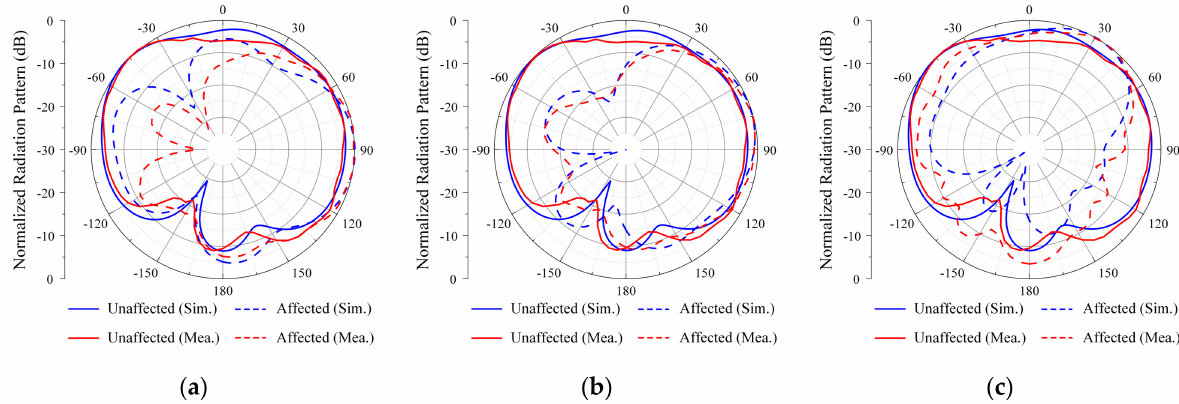
Figure 13. Simulated and measured normalized radiation of the IFA in the yz plane at 1.5 GHz: patterns at distances ( a ) 10 mm, ( b ) 40 mm, and ( c ) 110